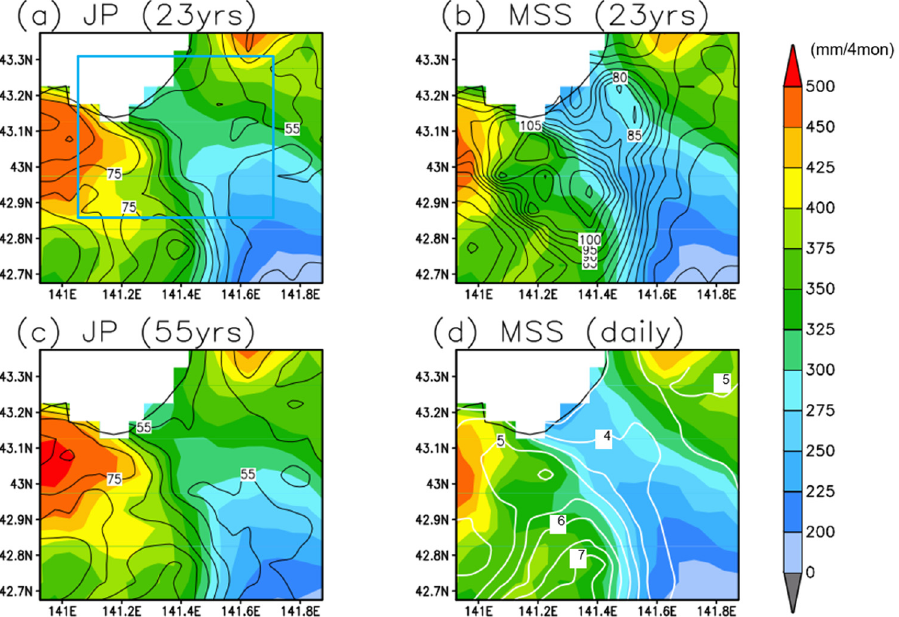
Figure 4. ( a ) Seasonal (December–March) averaged precipitation (color) for 1993–2015 by APHRO_JP. Black contours indicate standard deviation of seasonal precipitation during the 23 years (1993–2015). A light-blue rectangle indicates the target area; ( b ) same as ( a ) but for APHRO_JP + Multi Sensor Sapporo network (MSS); ( c ) same as ( a ) but for the 55 years (1961–2016); ( d ) same as Figure 2b (daily averaged precipitation and standard deviation. Unit of the precipitation (color) is mm per the four months (December–March). White contours indicate standard deviation (unit: mm/day, the same with that of Figure 2b).